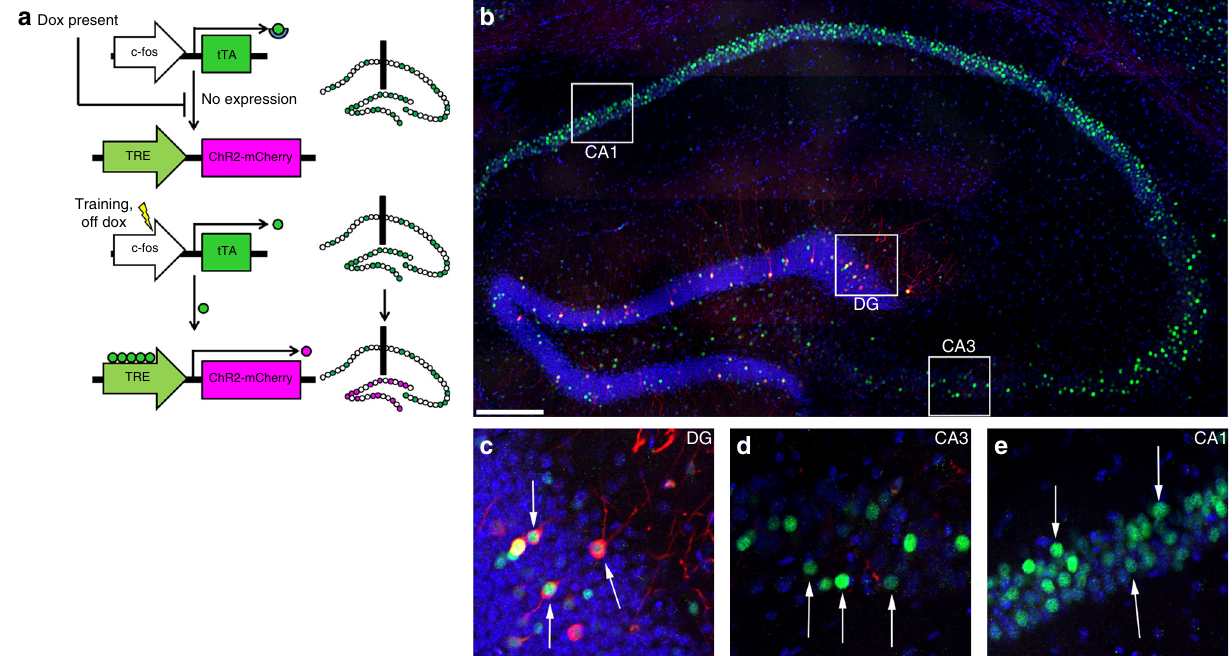
Fig. 1 Expression of ChR2-mCherry is restricted to the DG. a Expression of ChR2-mCherry in presence or absence of Dox. In the presence of Dox, tTA expressed through the c-fos promoter is unable to bind to the TRE promoter, suppressing expression of ChR2-mCherry. Withdrawal of Dox opens a window in which training labels a subpopulation of activated neurons with ChR2-mCherry. b Hippocampal section of a representative mouse after Dox withdrawal and FC training. Although a subpopulation of neurons in the entire hippocampus express c-Fos (DG, CA3, CA1; c – e ), expression of ChR2-mCherry is restricted to the DG ( c ). Scale bar: 200 µ m. Arrows: representative